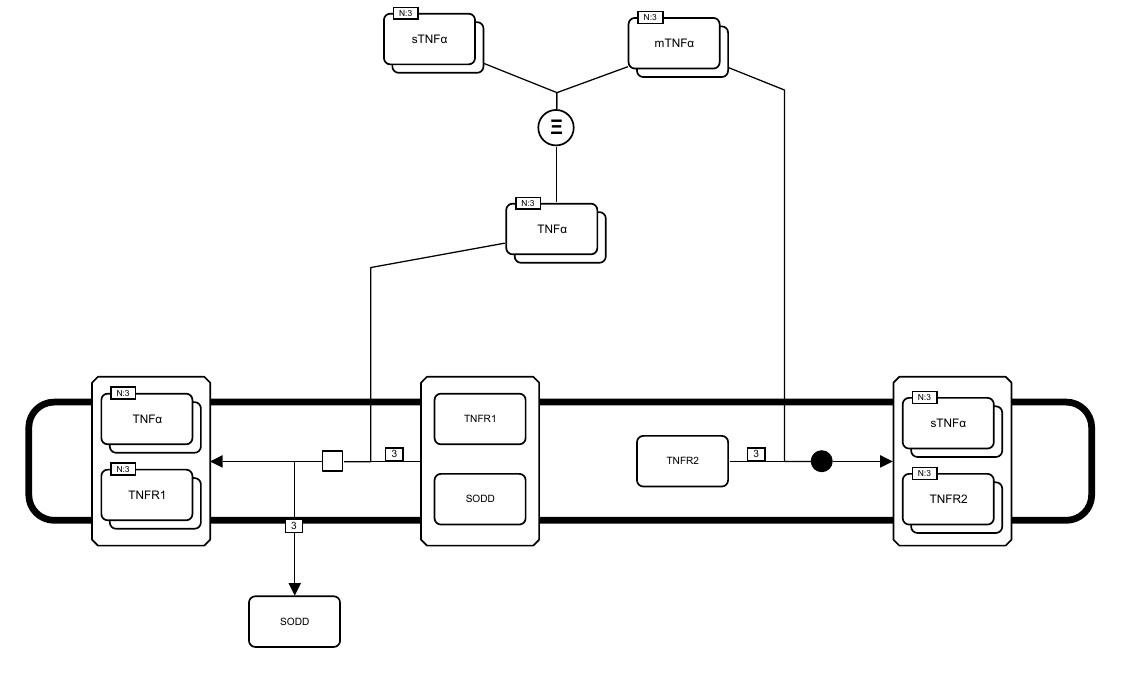
Figure 2.53: Binding of diverse forms of TNF α to TNF receptors.